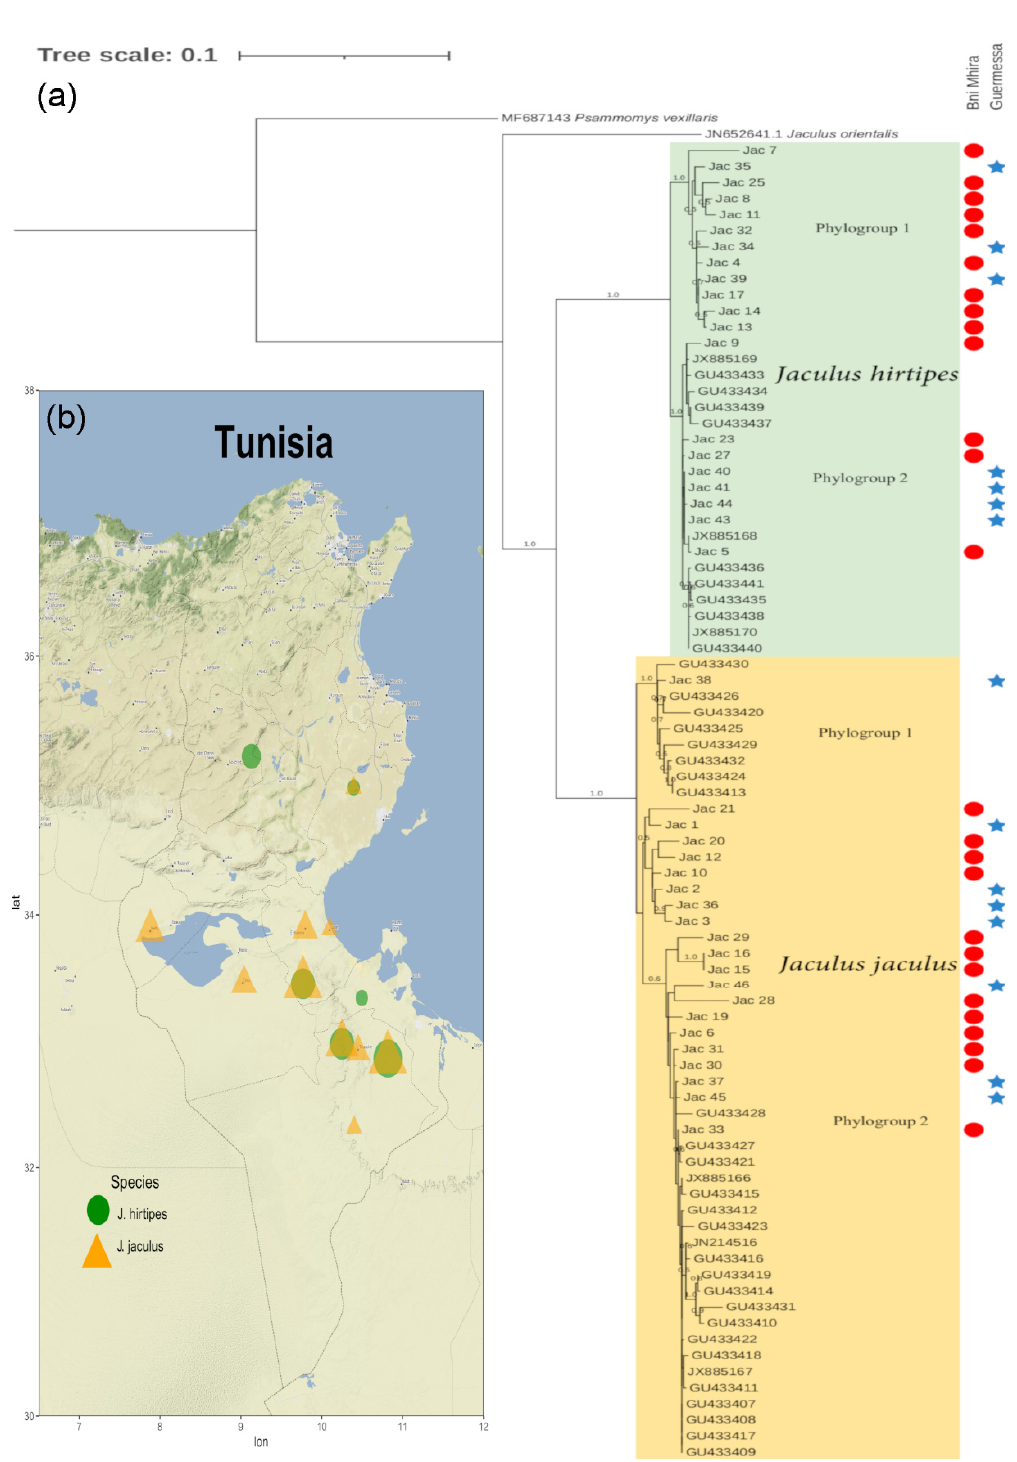
Figure 2. Phylogenetic relationship of new specimens and the Tunisian reference samples of J. jaculus and J. hirtipes , and their geographical distribution. ( a ): Phylogenetic tree based on maximum likelihood showing the relationship among Tunisian sequences for cytochrome b ( Cytb ) gene. Values on branches indicate bootstrap values. Jaculus orientalis and Psammomys vexillaris were used as outgroups. ( b ): Geographical locations of all Tunisian specimens used in the study assigned by rodent species. Yellow triangles and green circles correspond to J. hirtipes and J. jaculus , respectively. The size of the symbol is relative to the sample number at that location.